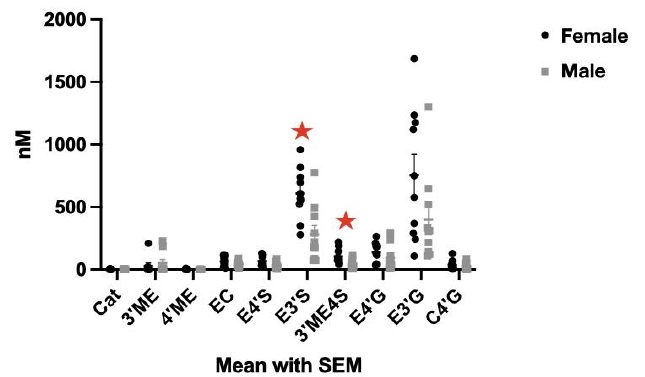
Figure 4. Abundance in the plasma of structurally related (-)-epicatechin (SREMs) metabolites by sex . An analysis of the single dose was conducted at V1 and V2 ( n = 20) . Catechin ( Cat ), (+)- 3′ - O